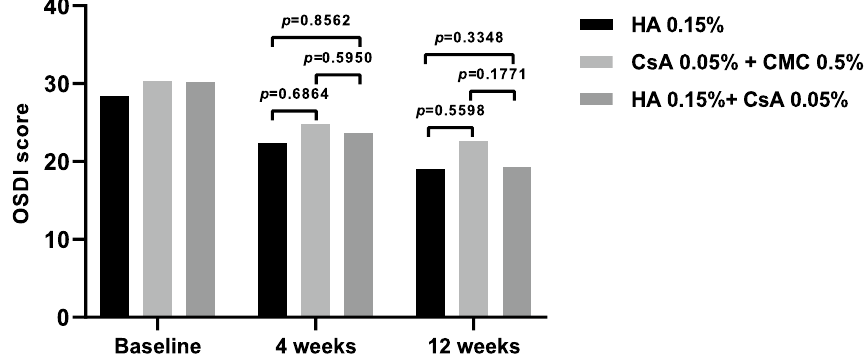
Figure 6. Ocular surface disease index (OSDI) scores at 4 and 12 weeks of the per-protocol set group. OSDI scores on each follow-up period showed no significant intergroup difference (Mean value ± standard deviation, P > 0.05 by analysis of